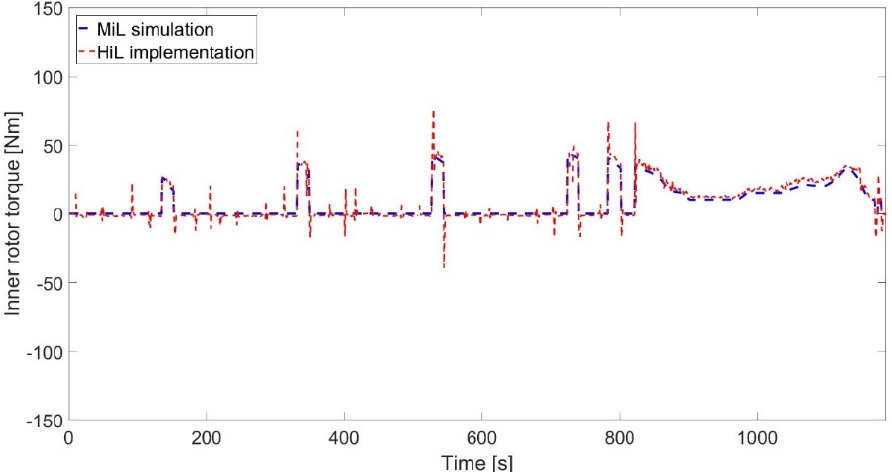
Figure 23. HiL (experimental) vs. MiL agreement results for the inner rotor torque, ECMS-based EMS.